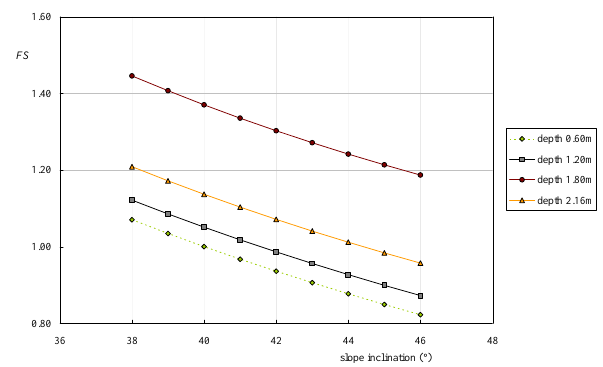
Figure 10 Fig. 10. Predicted minimum values of the safety factor at various depths during the event of December 1999 for different slope incli- nation